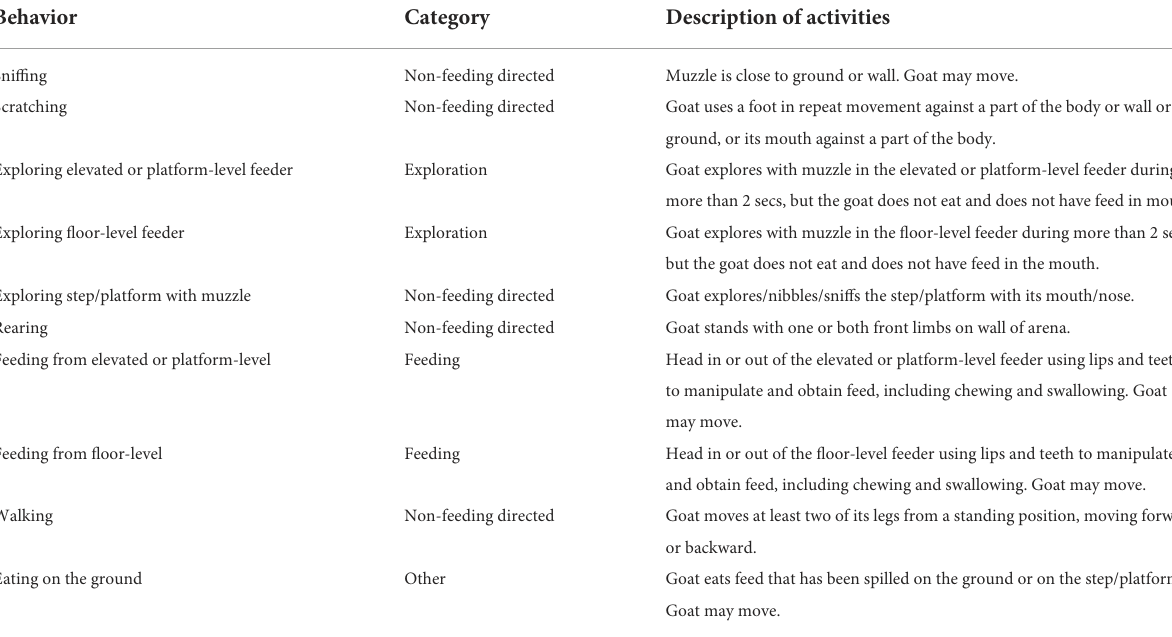
TABLE 3 Ethogram of behaviors coded for every goat during every 10-min test in Experiments 1 and